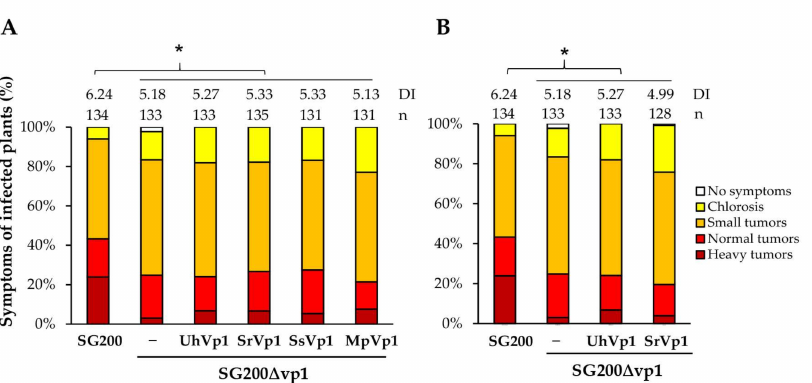
Figure 4. UmVp1 is functionally specialized in U. maydis . Pathogenicity assay of SG200 ∆ vp1 complemented with respective orthologs from Ustilaginaceae, expressed under umvp1 promoter using either their signal peptide ( A ) or UmVp1 signal peptide; ( B ) n indicates total numbers of infected plants from the three independent infection assays. DI is the average disease index value of three independent infection assays; * p < 0.05 indicates significant differences of disease symptoms in respective complementation strains compared with SG200 determined by a two-tailed Student’s t -test using the disease index values. Um, Ustilago maydis [16]; Uh, Ustilago hordei [37]; Sr, Sporisorium reilianum [7]; Ss, Sporisorium scitamineum